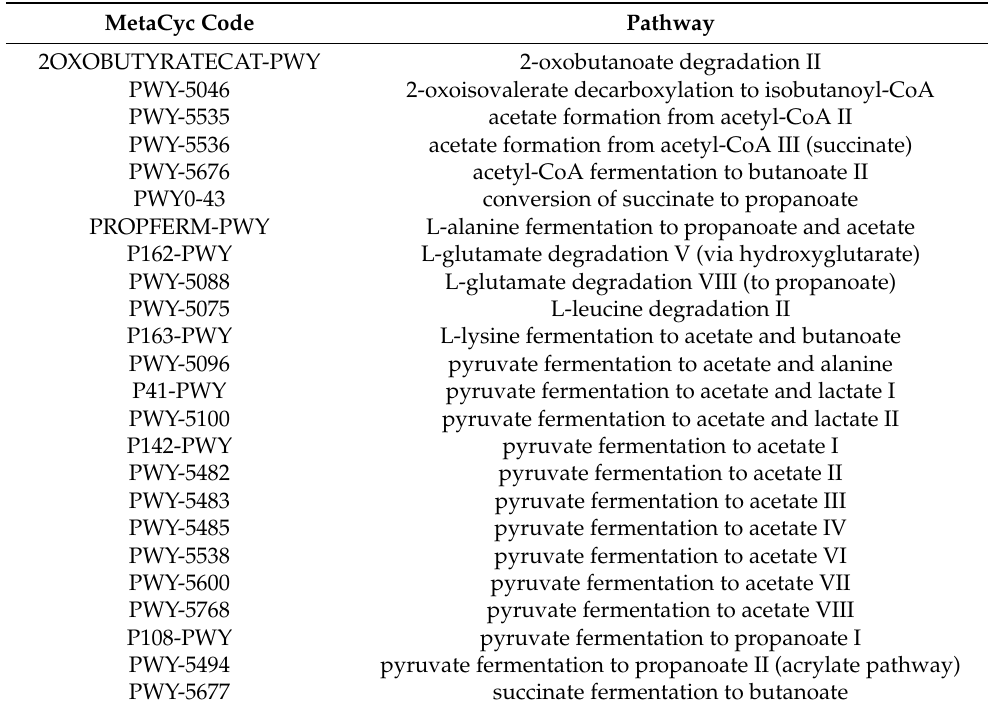
Table A1. The list of queried